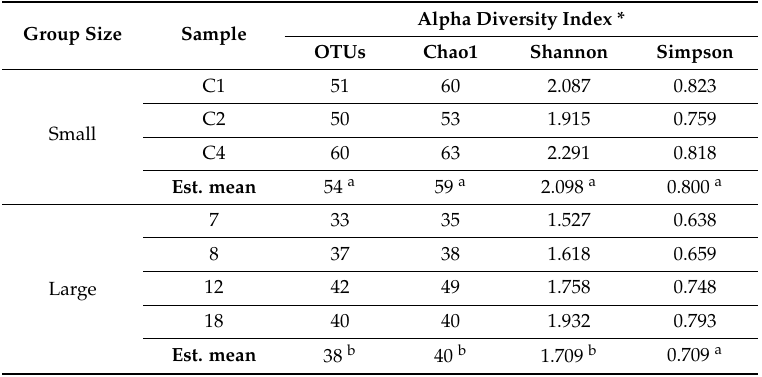
Table 1. Alpha diversity indices of small and large Arapaima gigas individuals.